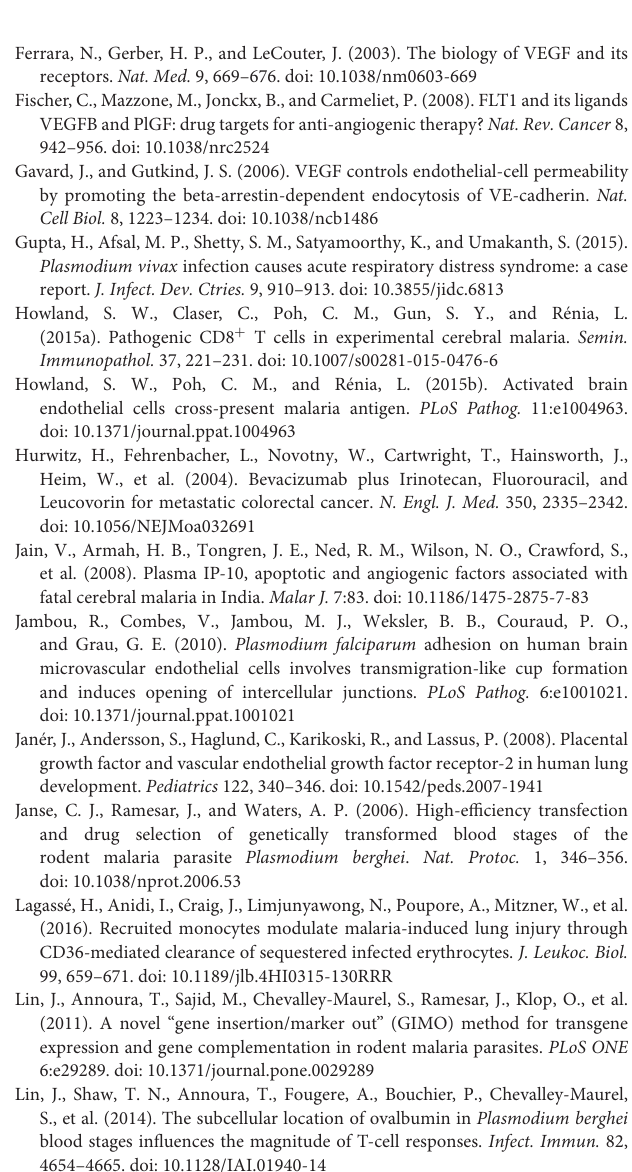
Supplementary Figure 4 | Schematic overview of anti-VEGFR-2 and sunitinib treatment in infected mouse lungs. This figure depicts a scheme of the interrelations of the VEGF-A and PlGF pathway with the anti-VEGFR-2 antibody (DC101 clone) and sunitinib treatment in infected mouse lungs. The target cells may be ECs, alveolar type II cells and macrophages. CD8 + T cells were shown to be essential for lung pathology. A downstream effect of this CD8 + T cell-mediated lung pathology is the expression of VEGF-A and PlGF in the lungs, whose receptors are VEGFR-1 and VEGFR-2. The anti-VEGFR-2 antibody inhibits the binding of VEGF-A to VEGFR-2, resulting in decreased VEGFR-2 activation. Sunitinib impairs the tyrosine kinase activity of VEGFR-1 and VEGFR-2 which leads to decreased activation of both receptor tyrosine kinases. However, both treatments did not impair CD8 + T cell-mediated lung pathology and sunitinib even aggravated the